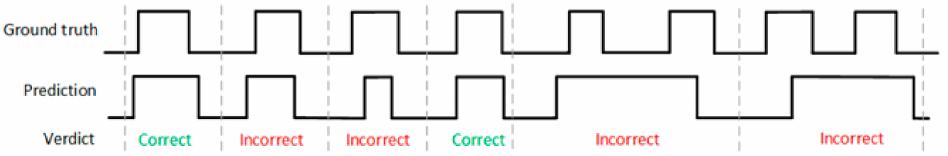
Figure 4. Layer diagram representation of the final hybrid CNN-MLP-based VAD system, using the same configuration example as in Figure 1.